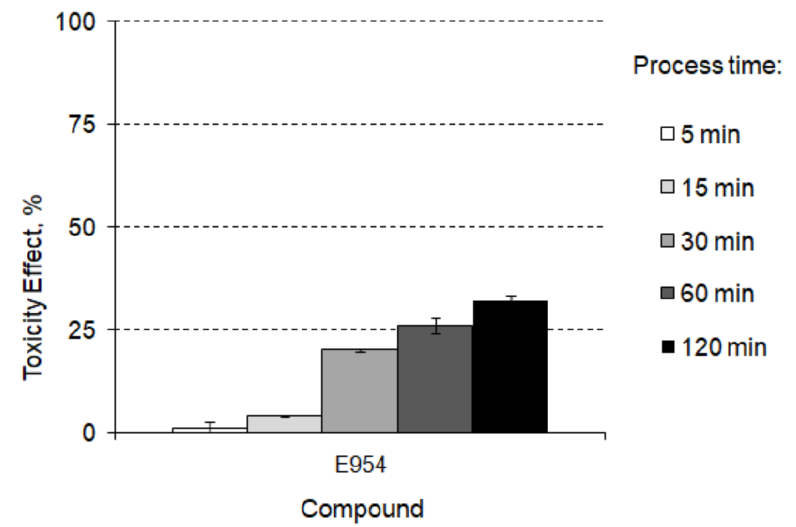
Figure 6. The toxicity change in the saccharine by-product formation pathway in swimming pool water installation.